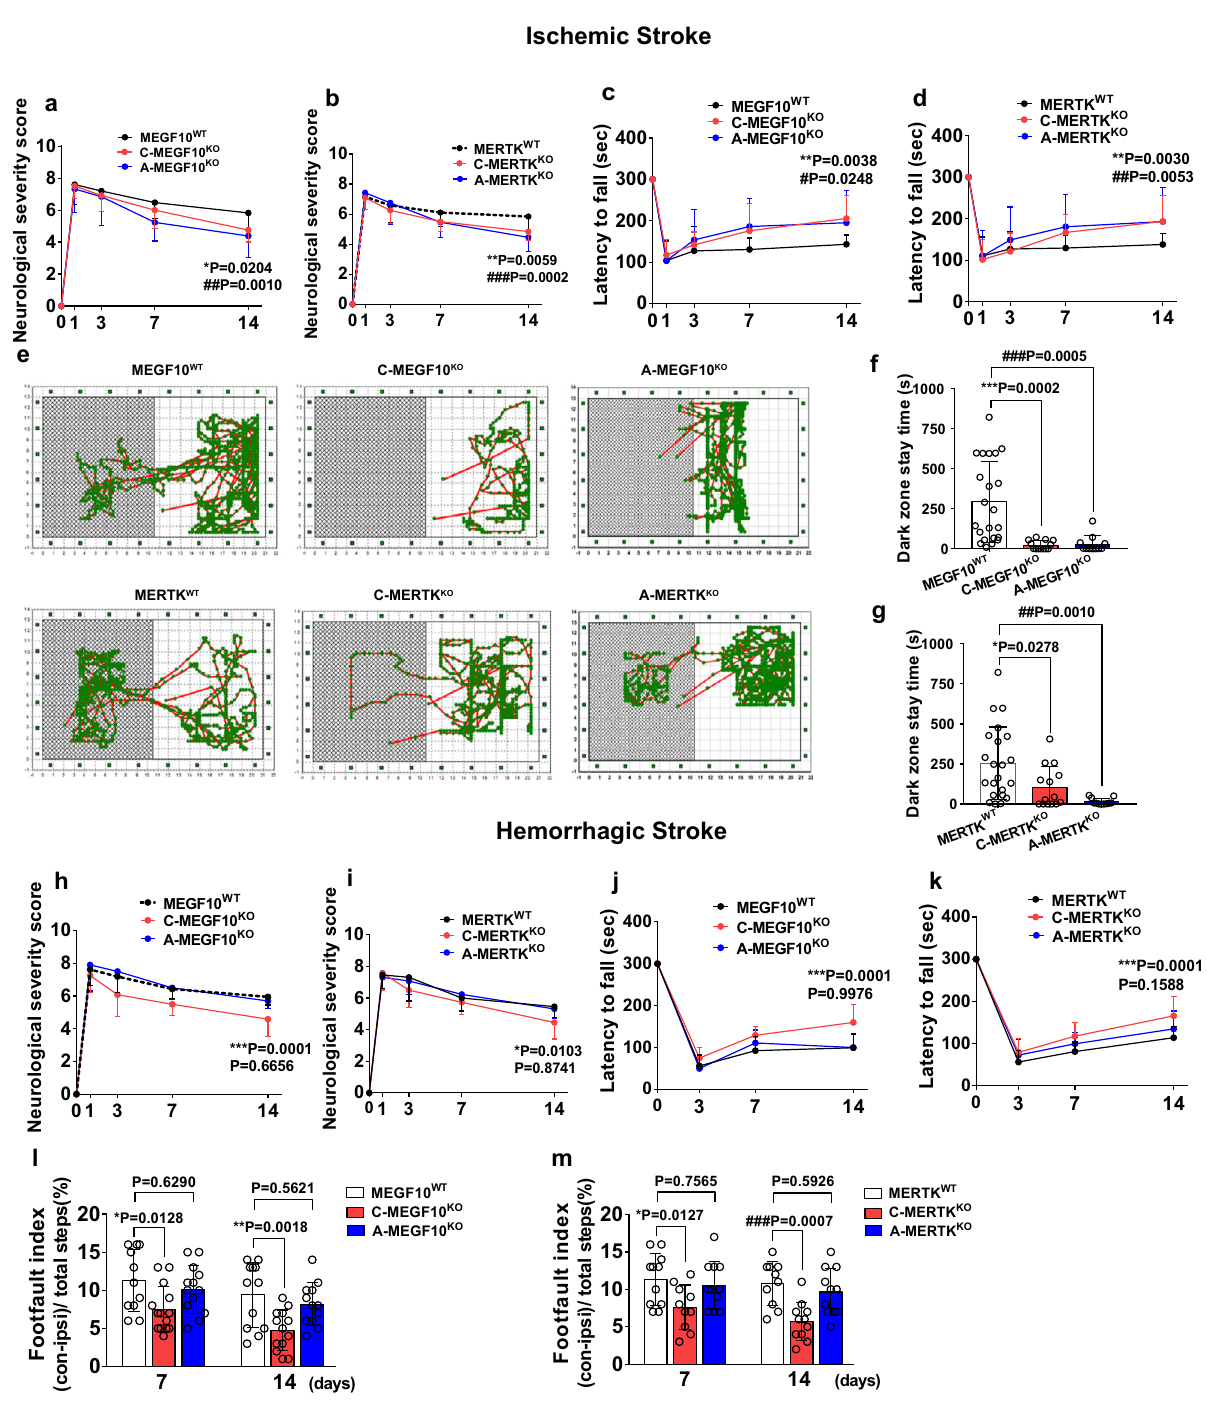
Fig. 9 Conditional MEGF10 or MERTK knockout in microglia/macrophages or astrocytes differentially affected behavioral outcomes in mice after ischemic and hemorrhagic stroke. mNSS ( a , b ) and rotarod test ( c – d ) were performed to examine the neurobehavioral outcomes of ischemic mice. *, MEGF10 WT VS C-MEGF10 KO , MERTK WT VS C-MERTK KO ; #, MEGF10 WT VS A-MEGF10 KO , MERTK WT VS A-MERTK KO . N = 17, 12, 13 mice ( a ); 19, 12, 11 mice ( b ); 11, 12, 10 mice ( c ); and 19, 13, 11 mice ( d ) (day 14, from left to right). e Representative images showed travel patterns in the smart cage. f , g Quanti fi cation of the time that mice of different groups stayed in the dark zone. N = 22, 17, 17 ( f ) and 22, 16, 15 mice ( g ) (from left to right). mNSS ( h – i ), rotarod test ( j – k ), and grid-walking test ( l – m ) were used to examine neurobehavioral outcomes of hemorrhagic mice at different time points. h – k *, MEGF10 WT VS C-MEGF10 KO , MERTK WT VS C-MERTK KO ; &, MEGF10 WT VS A-MEGF10 KO , MERTK WT VS A-MERTK KO . N = 21, 12, 10 mice ( h ); 11, 11, 13 mice ( i ); 12, 14, 11 mice ( j ); and 11, 14, 11 mice ( k ) (day 14, from left to right). N = 11, 14, 13, 11, 13, 12 mice ( l ) and 11, 10, 11, 10, 10, 11 mice ( m ) (from left to right). a – d , h – m Two-way ANOVA followed by Tukey ’ s test; f , g one-way ANOVA followed by Tukey ’ s test. Data are mean ±